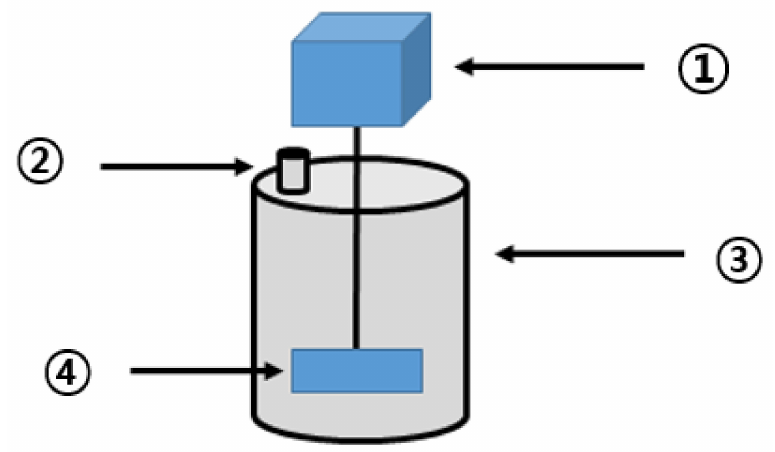
Figure 2. Anaerobic digester. (1: stirring motor; 2: biogas outlet; 3: high-temperature anaerobic digester; 4: stirring